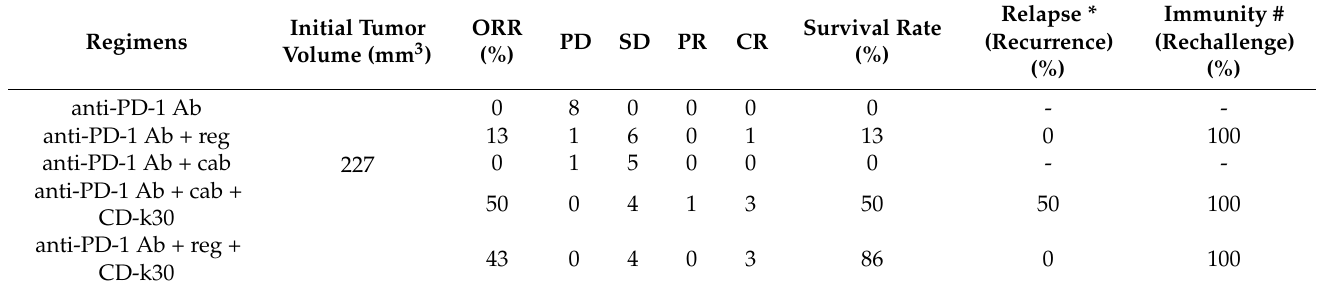
Table 1. The efficacy of HDAC inhibitor plus tyrosine kinase inhibitor with ICI in CT26 tumor-bearing mice